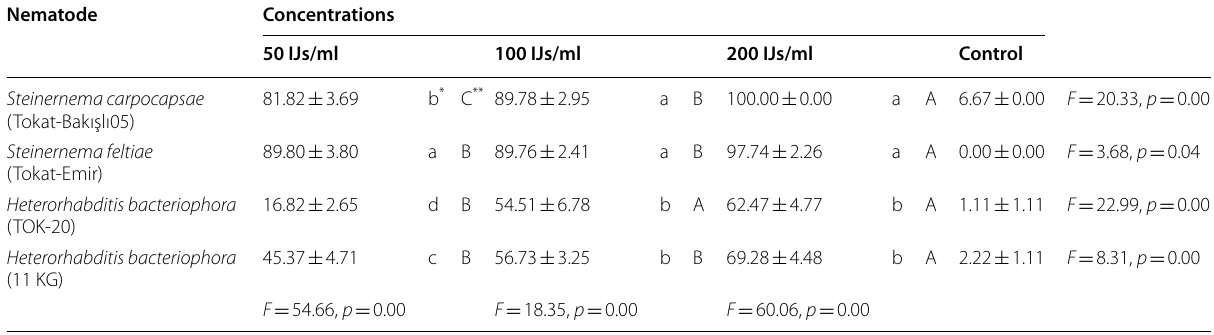
* Means within column bearing the same letter are not significantly different (Duncan’s test, p > 0.05) ** Means within lines bearing the same letter are not significantly different (Duncan’s test, p > 0.05)